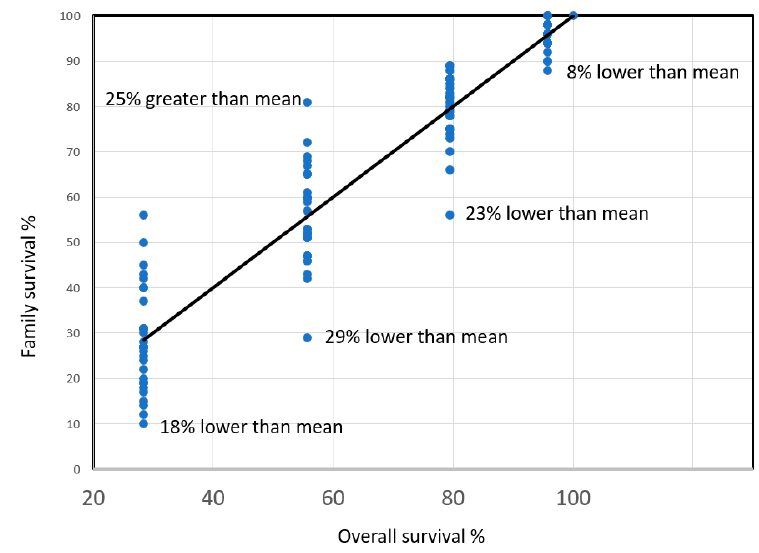
Figure 11. When planted in a good environment, the range in seedling survival among 30 loblolly pine families (100% to 88%) is relatively low [76]. As site conditions worsen, it becomes easier to identify families with low potential for survival when records are maintained and reviewed. Data from [76].